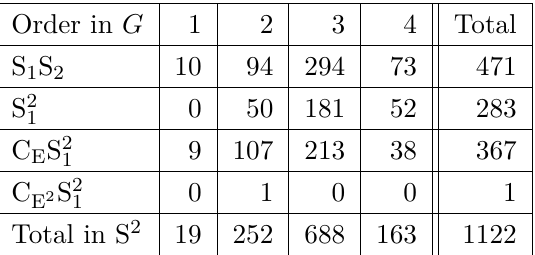
Table 1 . The number of graphs across topology orders in G in the N 3 LO quadratic-in-spin